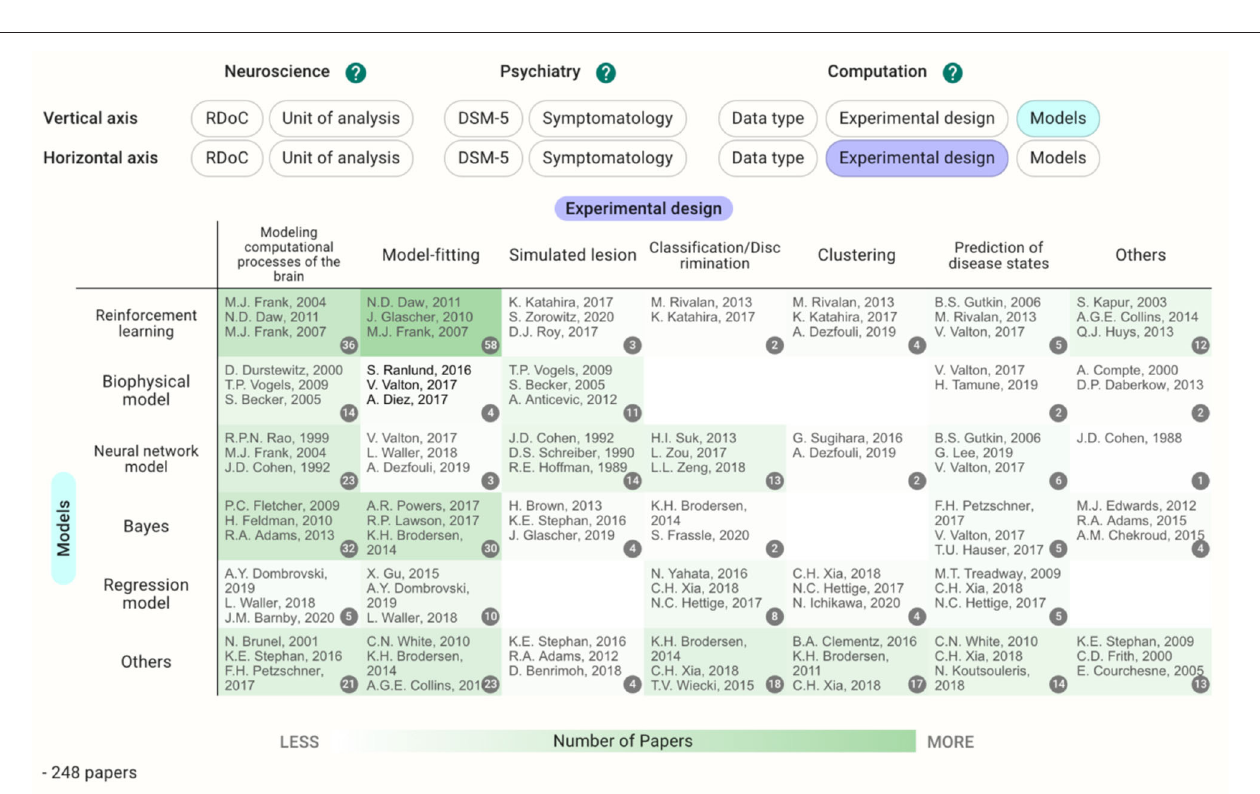
FIGURE 5 | Heatmap with models and experimental design as the vertical and horizontal axes, respectively. The cells with larger numbers of papers are shaded as deeper green.